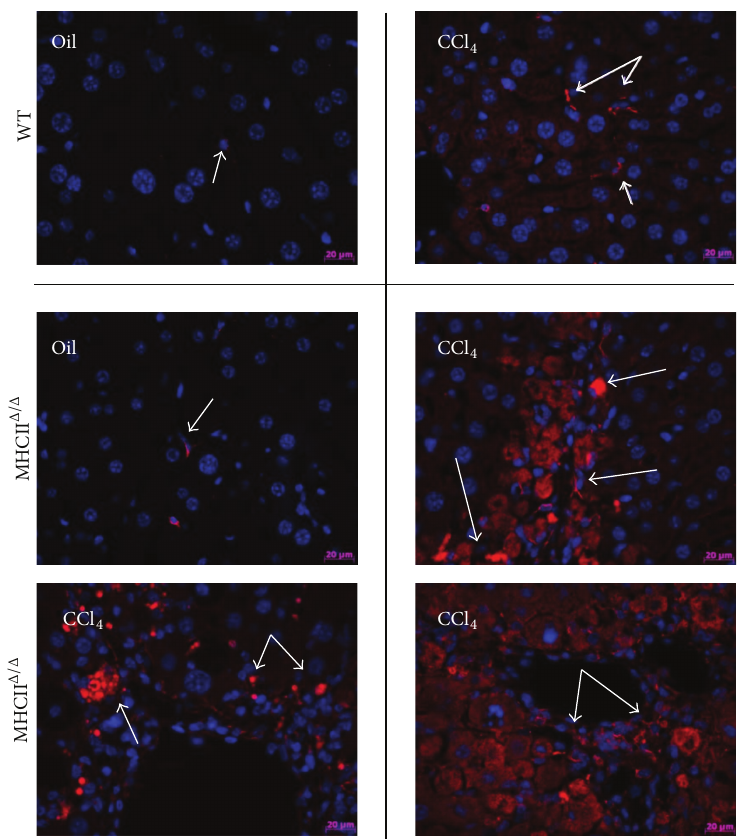
Figure 9: Effect of 4-week CCl 4 treatment on GFAP staining in wild-type and MHCII Δ/Δ mice. Glial fibrillary acidic protein (GFAP; white arrows) was stained in red. Increased positive staining was observed in CCl 4 -treated MHCII Δ/Δ mice. Blue: DAPI